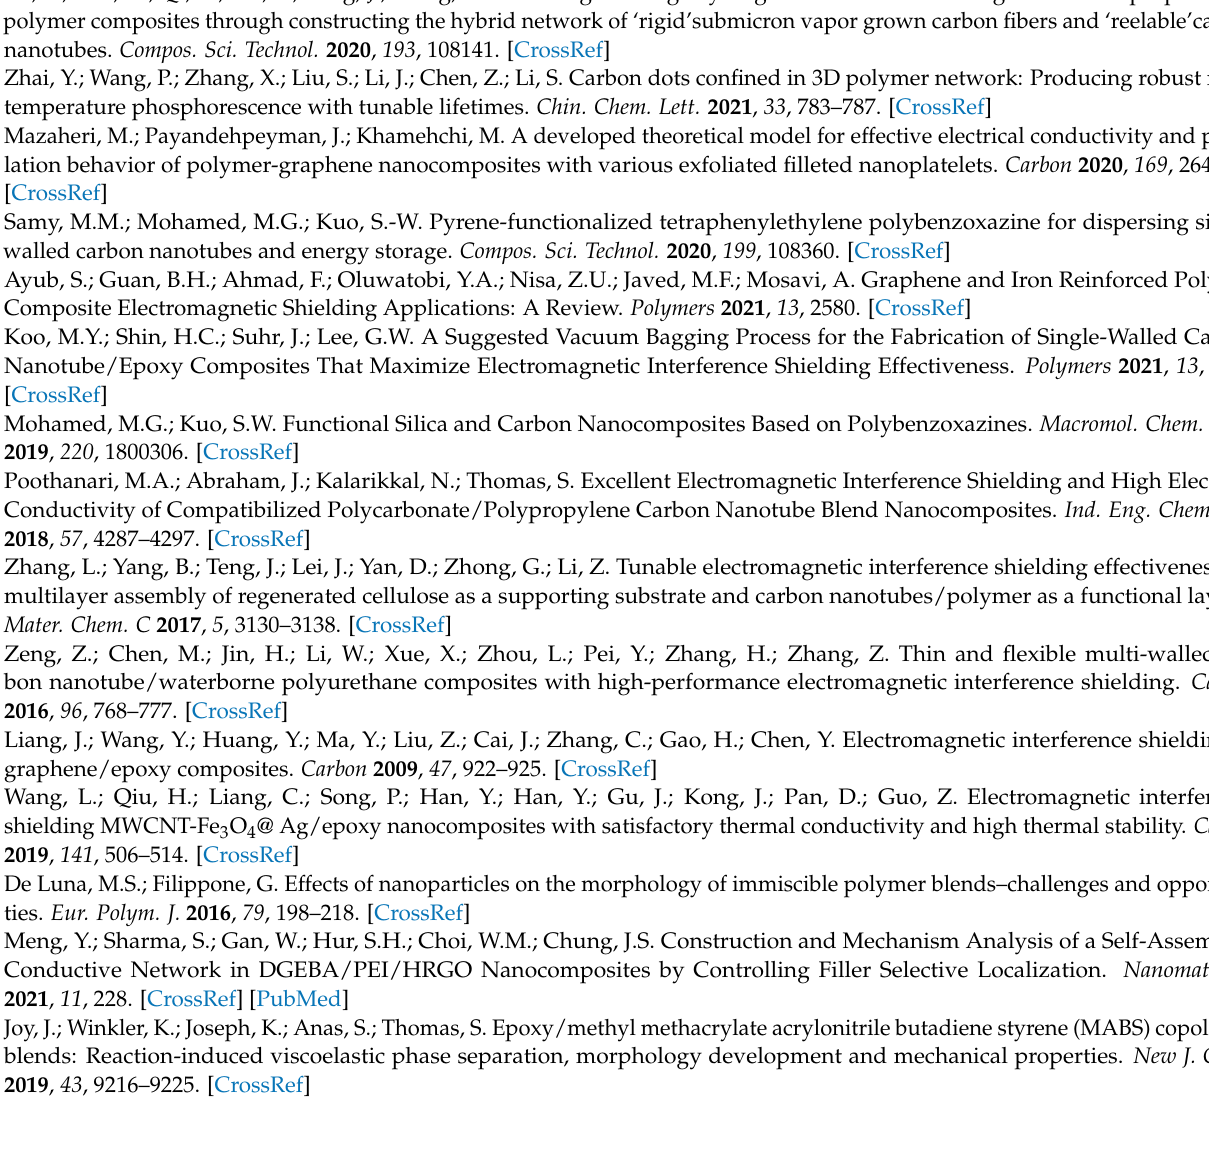
Table S6: The glass transition temperature T g (taken as the intersection of the extrapolation of baseline with the extrapolation of the inflexion) of samples. Table S7: The storage modulus and T g of various samples. Table S8: Comparison of EMI shielding performance with other